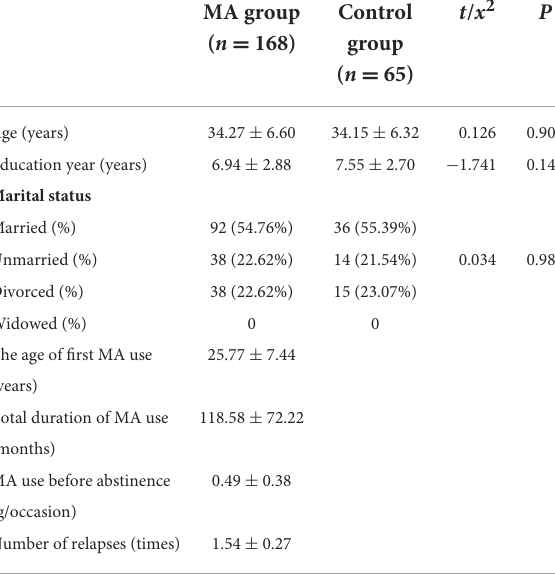
TABLE 1 Demographics and history of MA use in the MA group and control group.